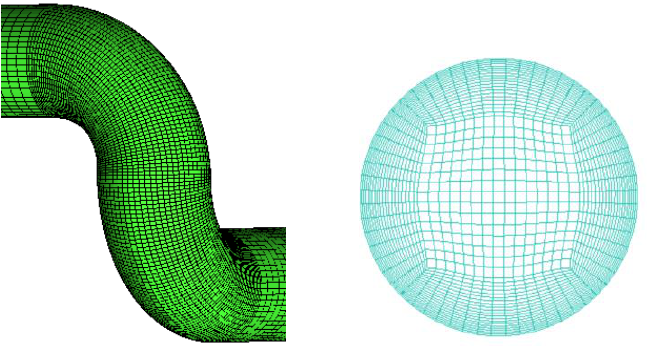
Figure 3. Gridding diagram.